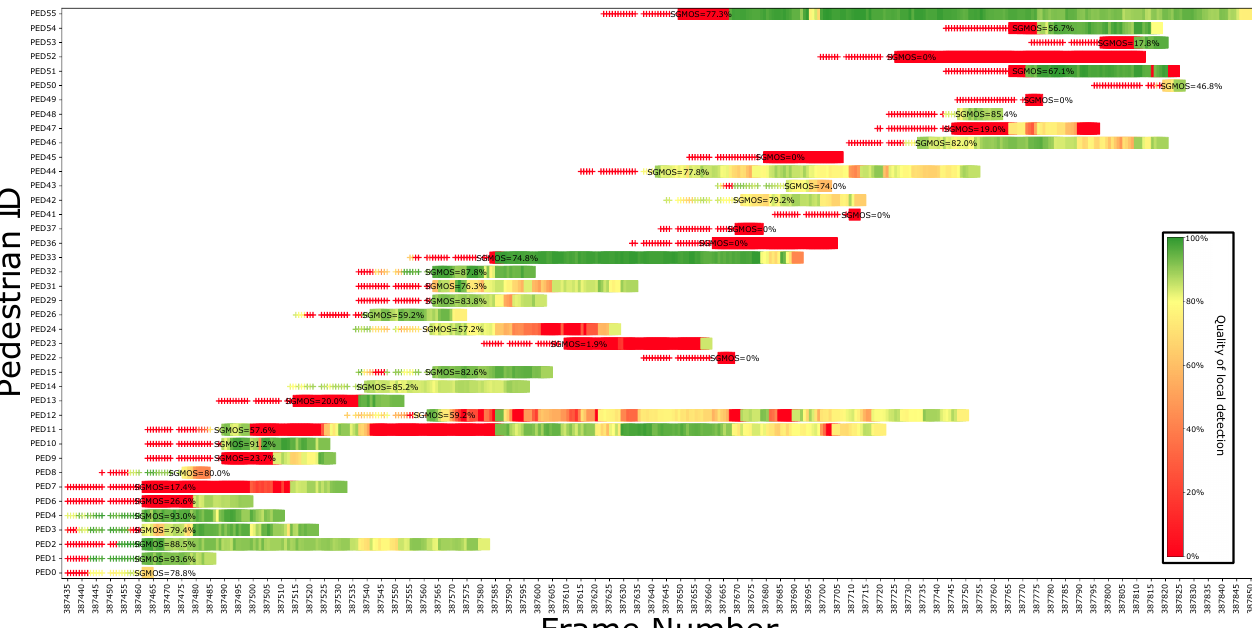
Figure 3. Weights calculation algorithm is designed to focus the evaluation type on the position of the first detection. This ensures that the calculation of mean will not blur the evaluation for the long appearance of objects, the results of the measure will be comparable for different events and its value will focus on the most crucial moment from the perspective of the automotive vehicle.